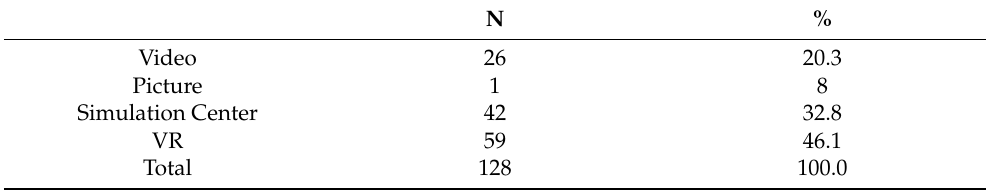
Table 2. Effective teaching media methods to be used in early childhood education institutions. N % Video